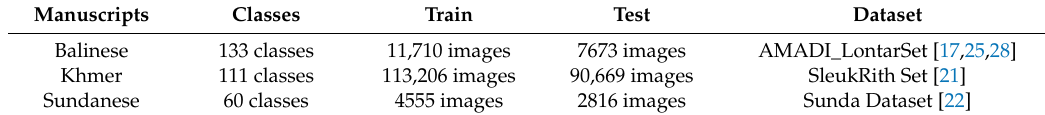
Table 3. For the Balinese character dataset, Balinese philologists manually annotated the segment of connected components that represented a correct character in Balinese script from the word-level